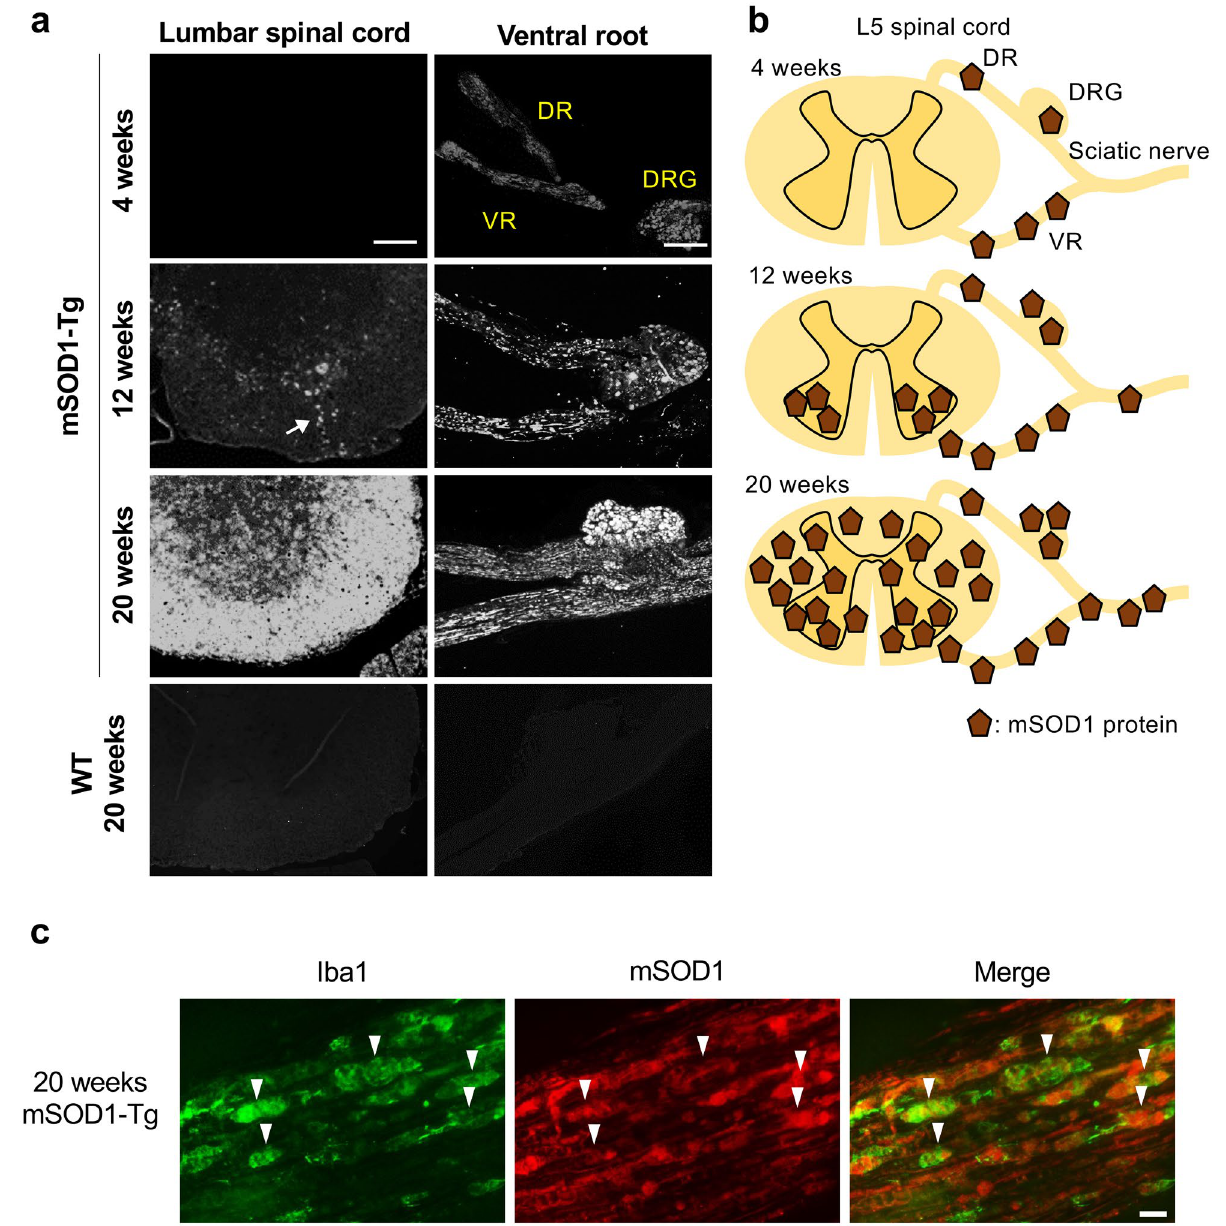
Figure 1. Immunostaining for mSOD1 and Iba1 in neural tissues. ( a ) Immunostaining for human mSOD1 in the lumbar spinal cord, dorsal root ganglia (DRG), ventral root (VR), and dorsal root (DR) from CCR2 RFP/WT / CX3CR1 GFP/WT (non-mSOD1 type) and SOD1 G93A / CCR2 RFP/WT / CX3CR1 GFP/WT (mSOD1-Tg) mice. Accumulation of mSOD1 protein in the DRG, VR, and DR prior to accumulation in the lumbar cord was apparent at 4 weeks of age. In the spinal cord, mSOD1 protein started to accumulate along the intramedullary lower motoneuron axonal tracts (arrow) at 12 weeks of age. ( b ) Schemas depict mSOD1 protein accumulation over the disease course in the mSOD1-Tg ALS mouse model. ( c ) Double immunostaining for Iba1 (green) and mSOD1 (red) in the sciatic nerves of a 20-week-old mSOD1-Tg mouse. All Iba1 + macrophages (arrowhead) harbored mSOD1 protein. Scale bars: ( a ) 200 μm (lumbar spinal cord), and 100 μm (DRG, VR, and DR): ( c ) 10